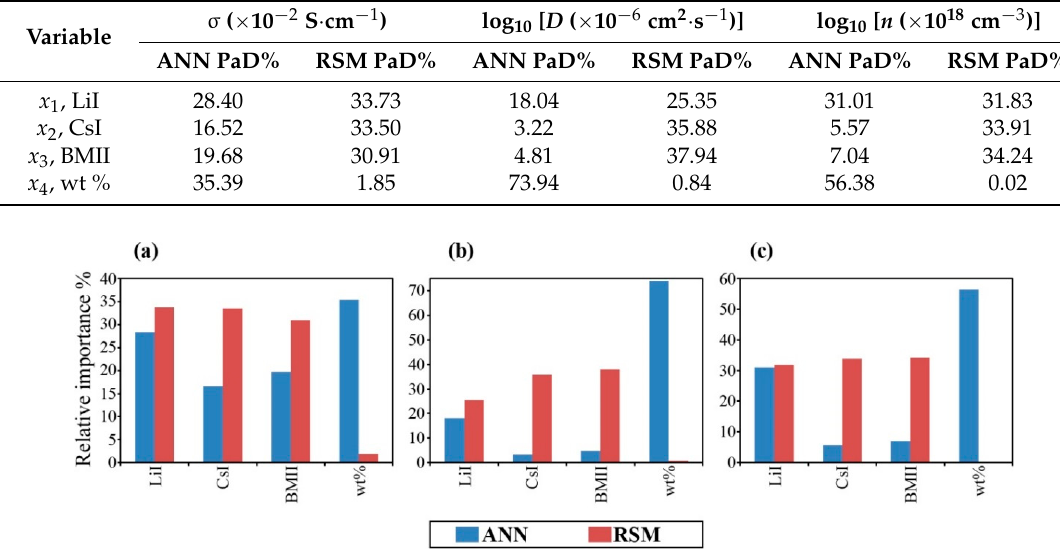
Figure 13. PaD relative importance% of single input factors towards the output response properties of ( a ) σ (×10 − 2 S·cm − 1 ); ( b ) log 10 [ D (×10 − 6 cm 2 ·s − 1 )]; and ( c ) log 10 [ n (×10 18 cm − 3 )].